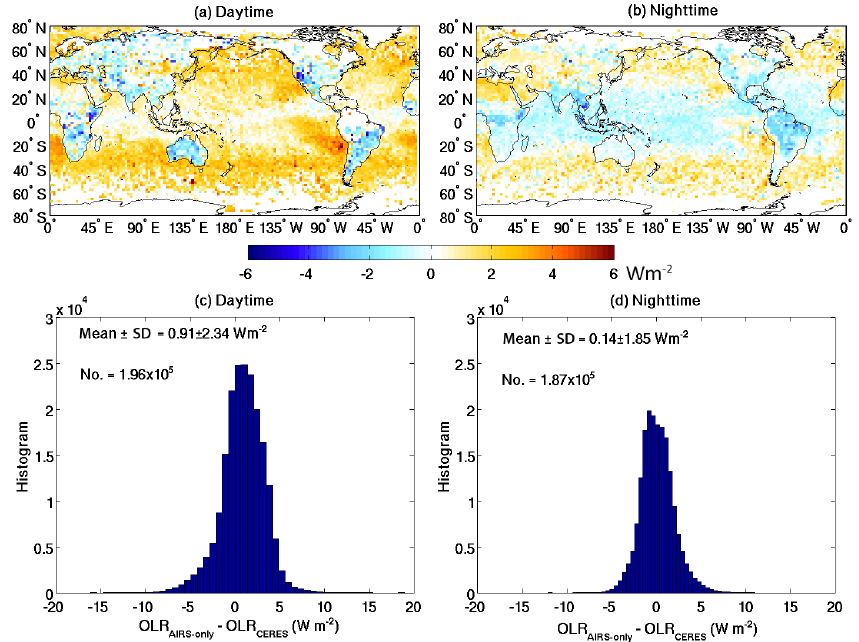
Figure 4. (a) Near-global distribution of annual-mean differences between daytime OLR derived from clear-sky AIRS nadir-view radiances using the algorithm in this study and the collocated CERES clear-sky daytime OLR (OLR AIRS-only –OLR CERES ) . The data in 2004 are used and averaged onto 2.5 ◦ longitude by 2 ◦ latitude grids. (b) Same as (a) but for annual-mean nighttime OLR differences. (c) The histograms of daytime OLR AIRS-only –OLR CERES differences among all collocated AIRS and CERES nadir-view footprints. (d) Same as (c) but for the histogram of nighttime OLR AIRS-only –OLR CERES differences. Fifty bins are used in both (c) and (d) . The mean differences ± standard deviations and number of observations are also labeled on the